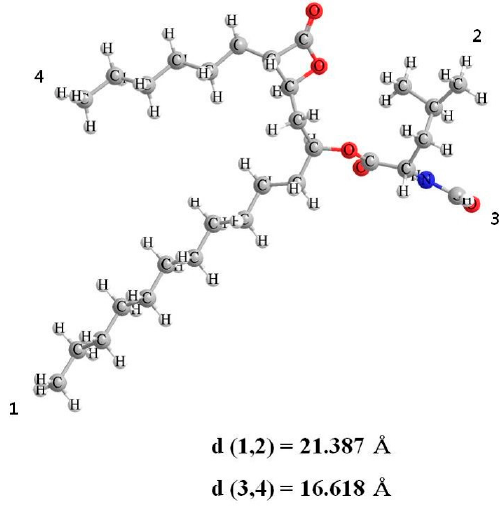
Figure 1. Chemical structure of orlistat.